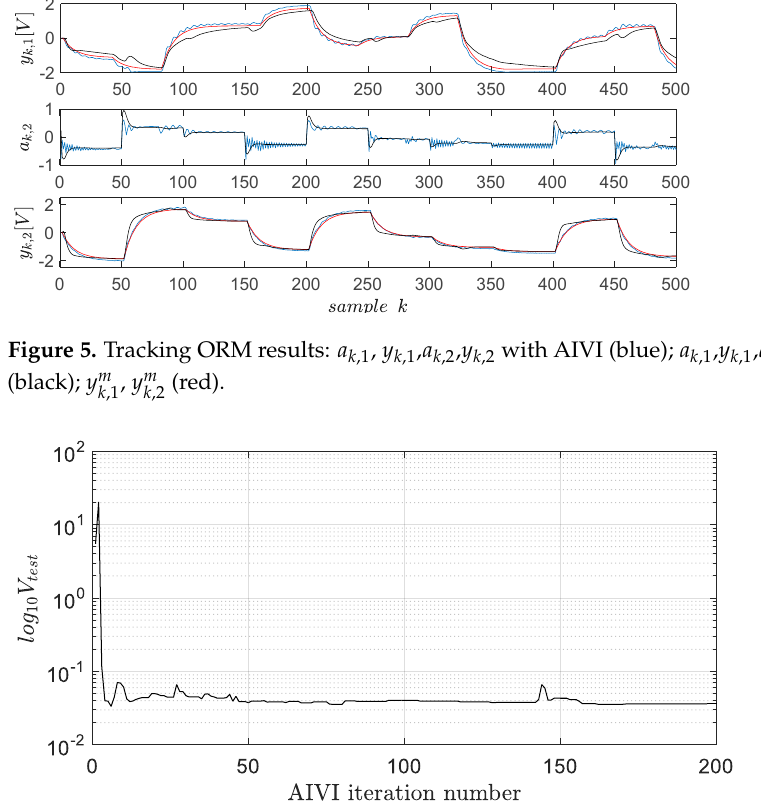
Figure 6. ORM tracking performance V test throughout AIVI, measured on the test scenario for 200 iterations.